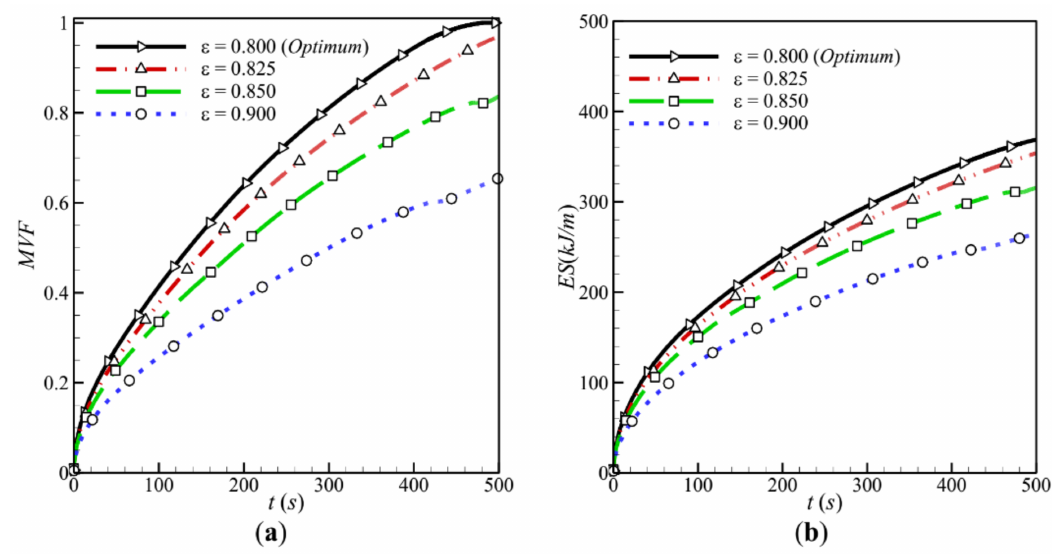
Figure 7. The effect of various average porosity ( a ) on the melting volume fraction and ( b ) energy stored when VF na = 0.01, a = − 2, γ = 2 π /4, and PPI = 25.